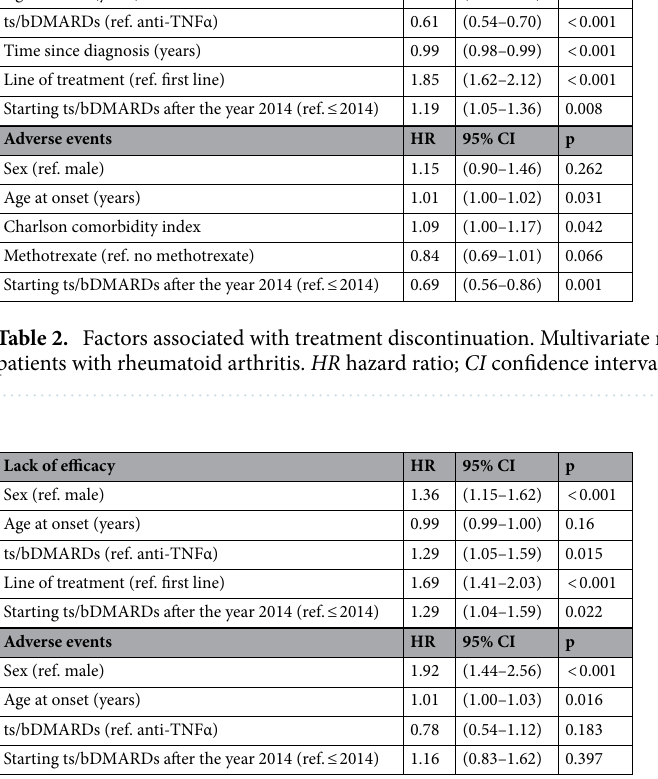
Table 3. Factors associated with treatment discontinuation. Multivariate regression model in the group of patients with psoriatic arthritis. HR hazard ratio; CI confidence interval.